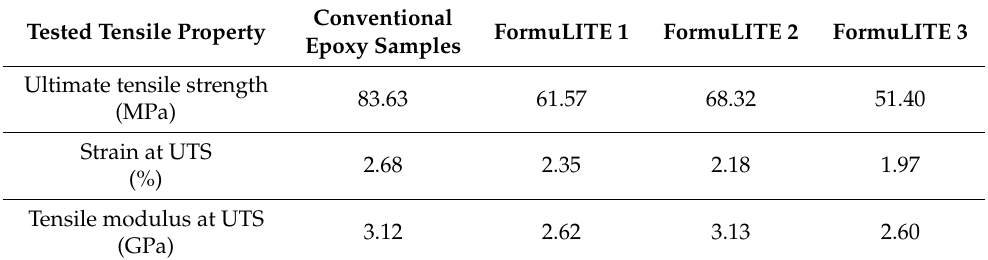
Table 2. Tensile properties of the conventional and bio-based epoxy